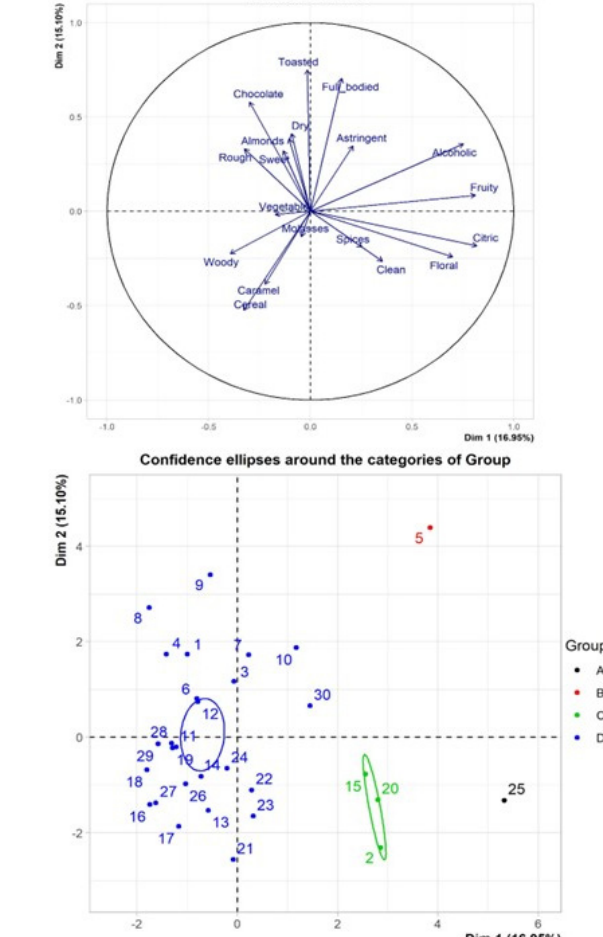
Figure 5. Principal component analysis in relation to the first two components, obtained from the nuances ( A ). Scatter diagram in relation to the first two main components, obtained from the nuances characteristics of 30 coffees obtained from 5 treatments of Conilon ( Coffea canephora ) and 6 locations ( B